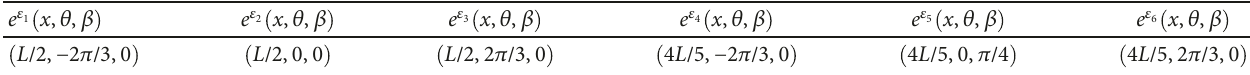
Figure 6: Static test setup. The single beam (A), frame structure (B), and NDI Optotrak Certus Table 1: Optical fi ber sensor location in one element.